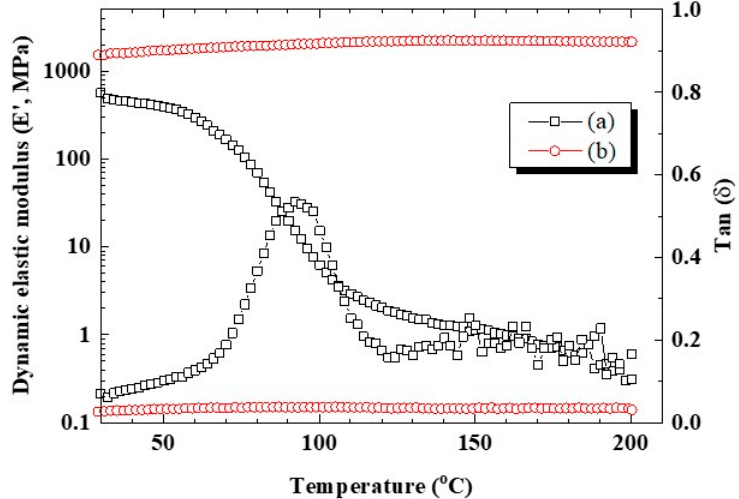
Figure 3. Dynamic elastic modulus and Tan δ of ( a ) Nafion212 and ( b ) CSPPSU membranes at 1 Hz.